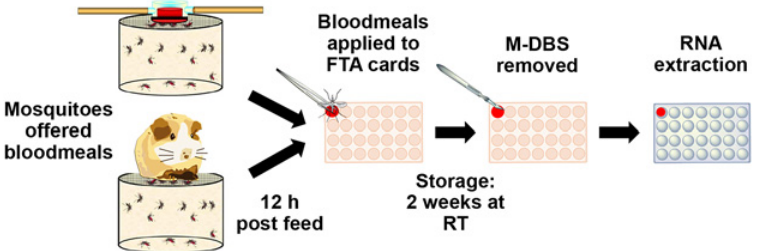
Fig 1. Laboratory preparation of mosquito bloodmeals for detection of viral RNA. Mosquitoes were offered bloodmeals from artificial membrane feeders containing virus-spiked sheep ’ s blood or virus-infected hamsters. The bloodmeals were applied to FTA cards 12 h post blood feeding, unless otherwise indicated. The FTA cards were left to air dry for 2 hours and stored at room temperature for 2 weeks. The mosquito dried blood spots (M-DBS) were removed from the FTA cards and RNA was